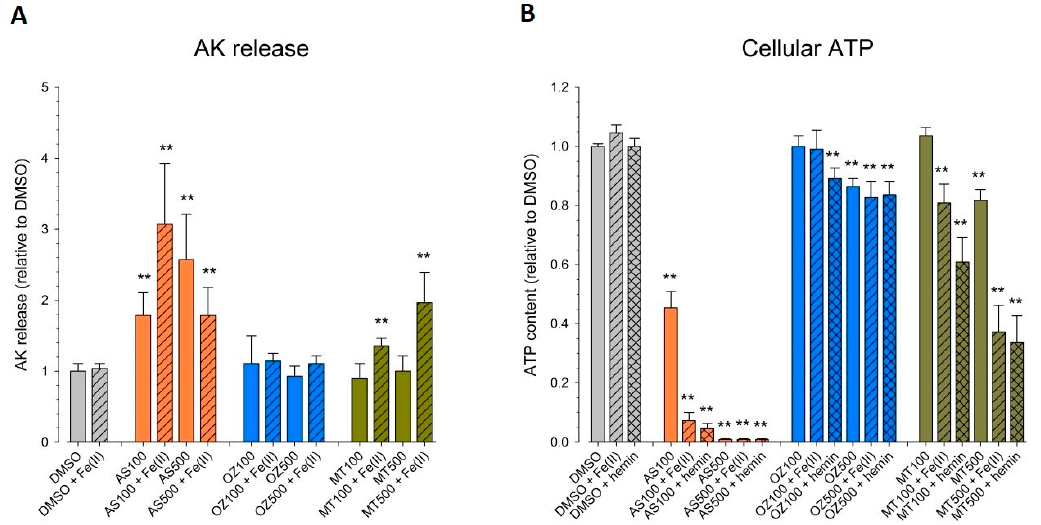
Figure 3. Iron-mediated increase in adenylate kinase (AK) release and depletion of ATP in HepG2 cells treated with AS, OZ78, or MT04. HepG2 cells were treated with AS, OZ78, or MT04 (100 or 500 µM) alone or in the presence of Fe 2+ or hemin for 24 h. ( A ) AK release expressed relative to DMSO. Triton-X was used as positive control reflecting complete cell lysis (7-fold increase compared to DMSO, data not shown). ( B ) Intracellular ATP content expressed relative to DMSO control. Results represent the mean of five independent experiments carried out in triplicates. Data represent the mean ± STD. Asterisks indicate significance compared to DMSO control, ** p < 0.01 vs. control incubations